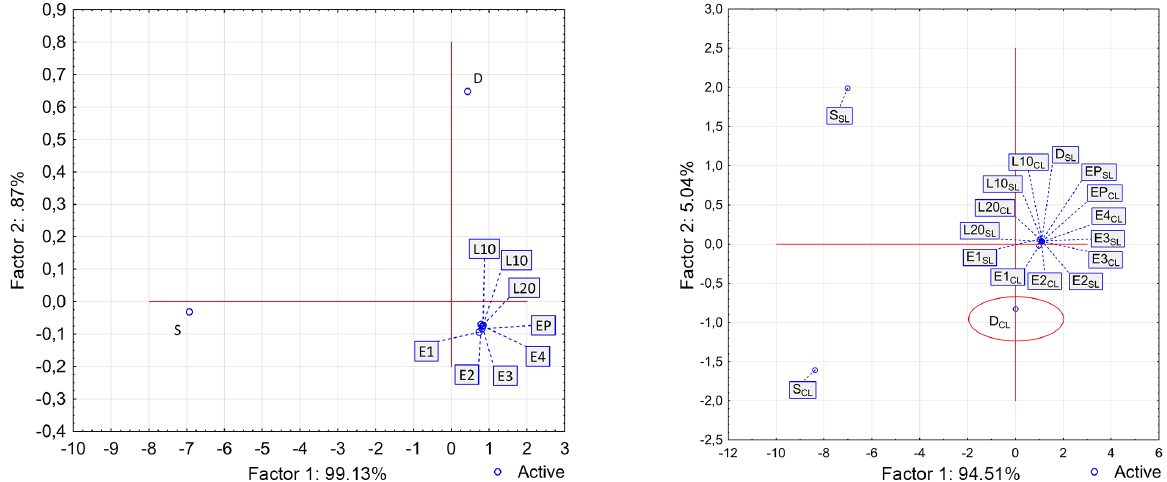
FIGURE 4 - Principal Component Analysis method application, allowing the gathering of similar behavior data groups. ( A ) Differentiation of variables swab and dermis when submitted to laser treatment, ( B ) differentiation of dermis with laser (DCL) and swab with and without laser (SCL and SSL) compared to the results set considering all tested